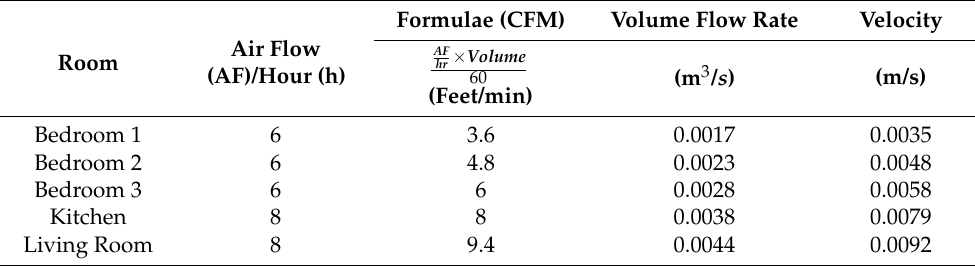
Table 3. Calculated air flow rate for each room with a total volume flow rate of 0.015 m 3 /s